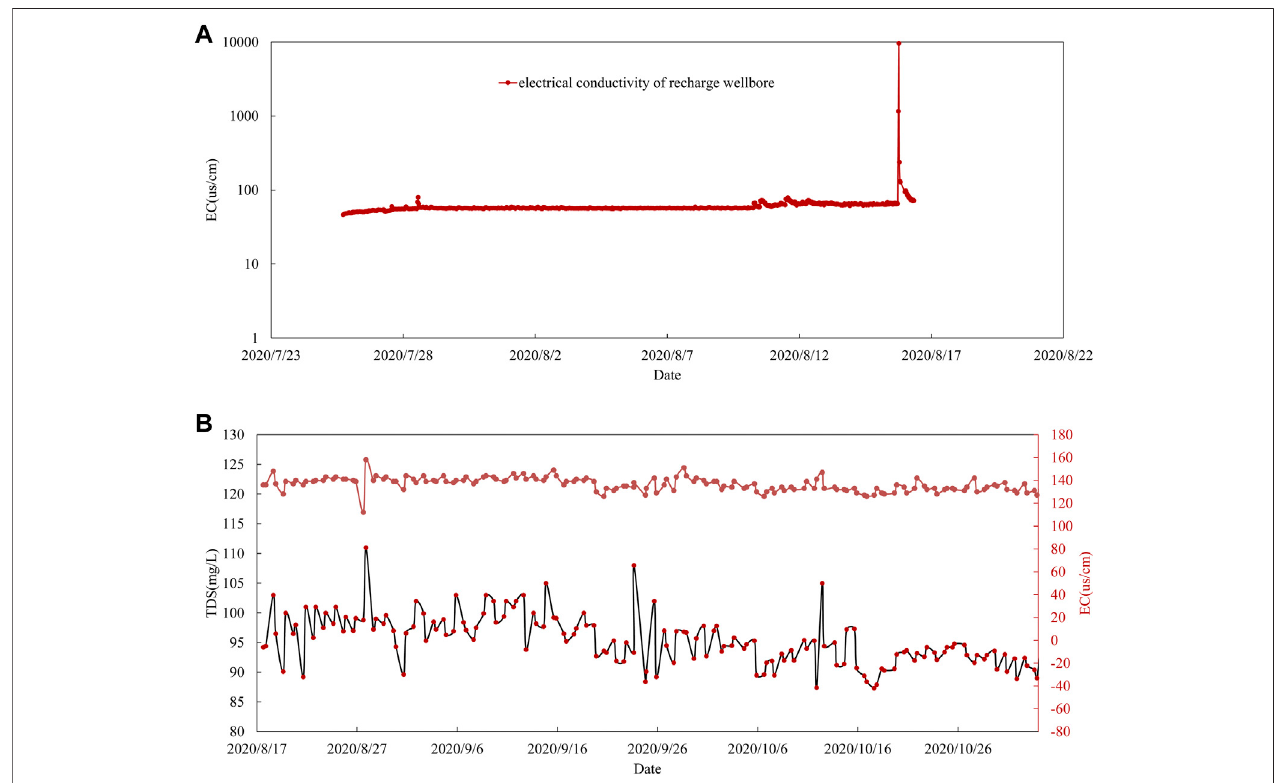
FIGURE11| ThemonitoringdataoftheKLexploitationwellboreinthehydraulicconnectiontest. (A) Electricalconductivityvariationoftherechargeareabeforeand right after the hydraulic connection test; (B) the TDS and electrical conductivity (EC) during the later 3 months.